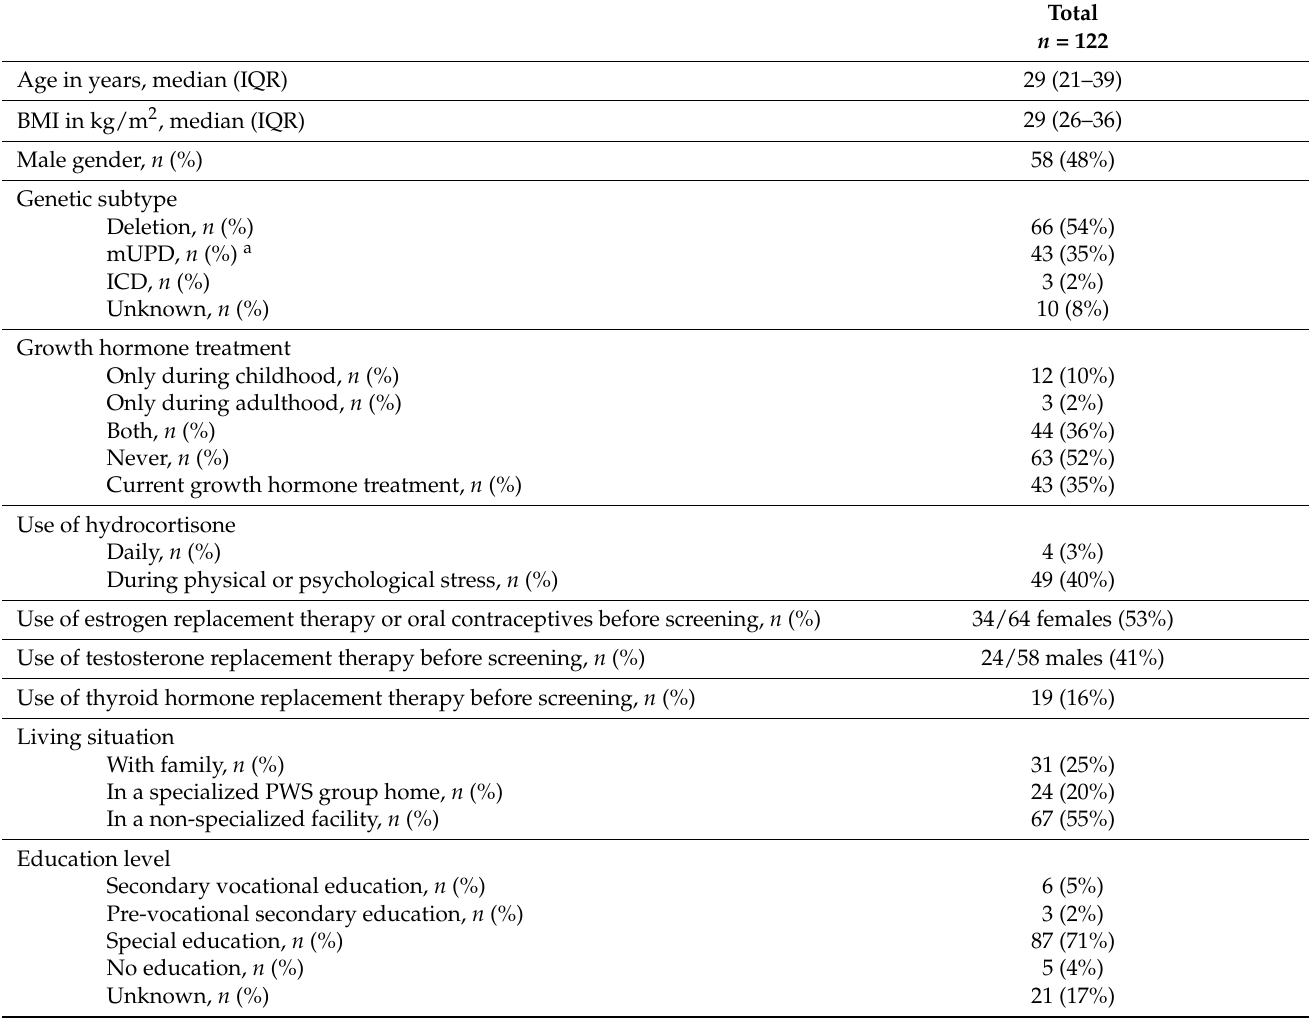
Table 1. Baseline characteristics of 122 adults with Prader–Willi